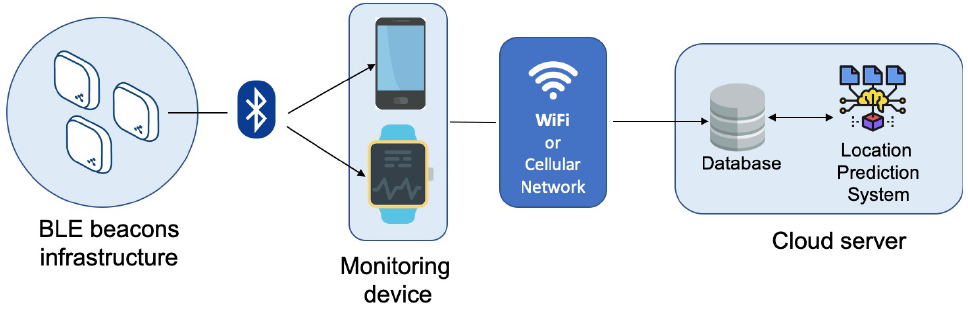
Figure 1. The system’s overall